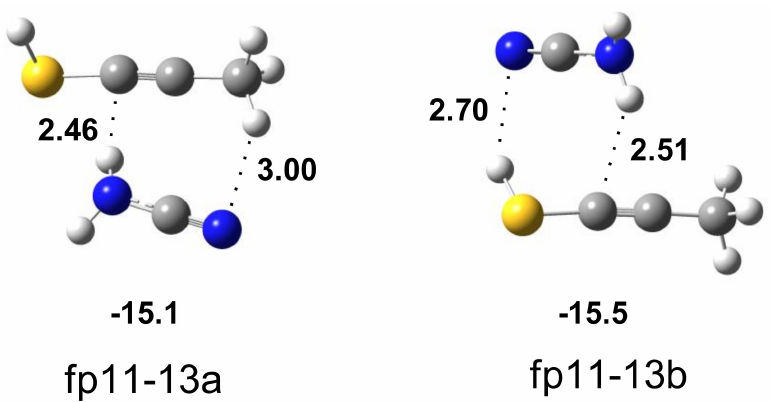
Figure 6. B3LYP/6-311++G(3df,3pd) optimized structures of the H 2 N–C ≡ N ··· CH 3 C ≡ CSH